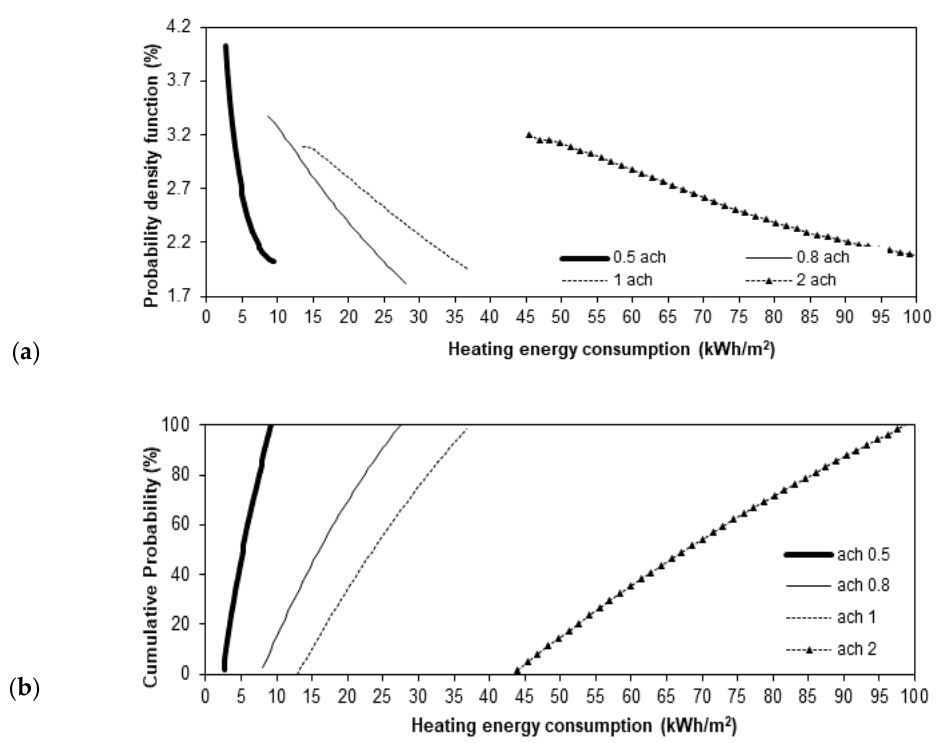
Figure 4. Probability density functions ( a ) and cumulative probability ( b ) of the heating energy consumption for an increment of +0.5 °C in the outdoor temperature.